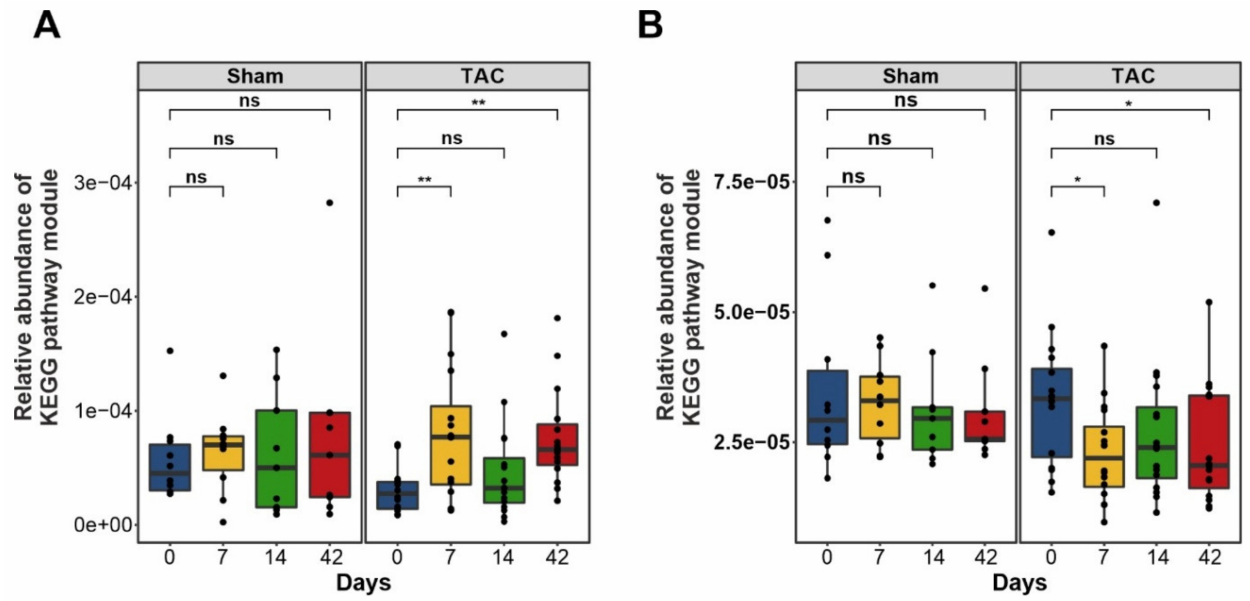
Figure 6. Box plot showing differences in the abundances of genes involved in the TMAO pathway in the Sham and TAC samples. ( A ) Differences in the abundances of the torZ gene are shown for the TAC and Sham samples. Significant differences in the torZ concentrations in TAC samples at the 1st and 6th weeks were found as compared to the initial TAC samples (0th week) using Wilcoxon’s test. ( B ) Differences in the abundances of the betaine/carnitine transporter involved in the TMAO pathway are shown for the TAC and Sham samples. The Wilcoxon’s test showed a significant decrease in gene concentration at the 1st and 6th weeks in the TAC samples. ( n values are as follows: Sham day 0 = 10, day 7 = 10, day 14 = 9, day 42 = 9; TAC day 0 = 16, day 7 = 16, day 14 = 16, day 42 = 15). * and ** correspond to p ≤ 0.05, p ≤ 0.01 respectively; ns,